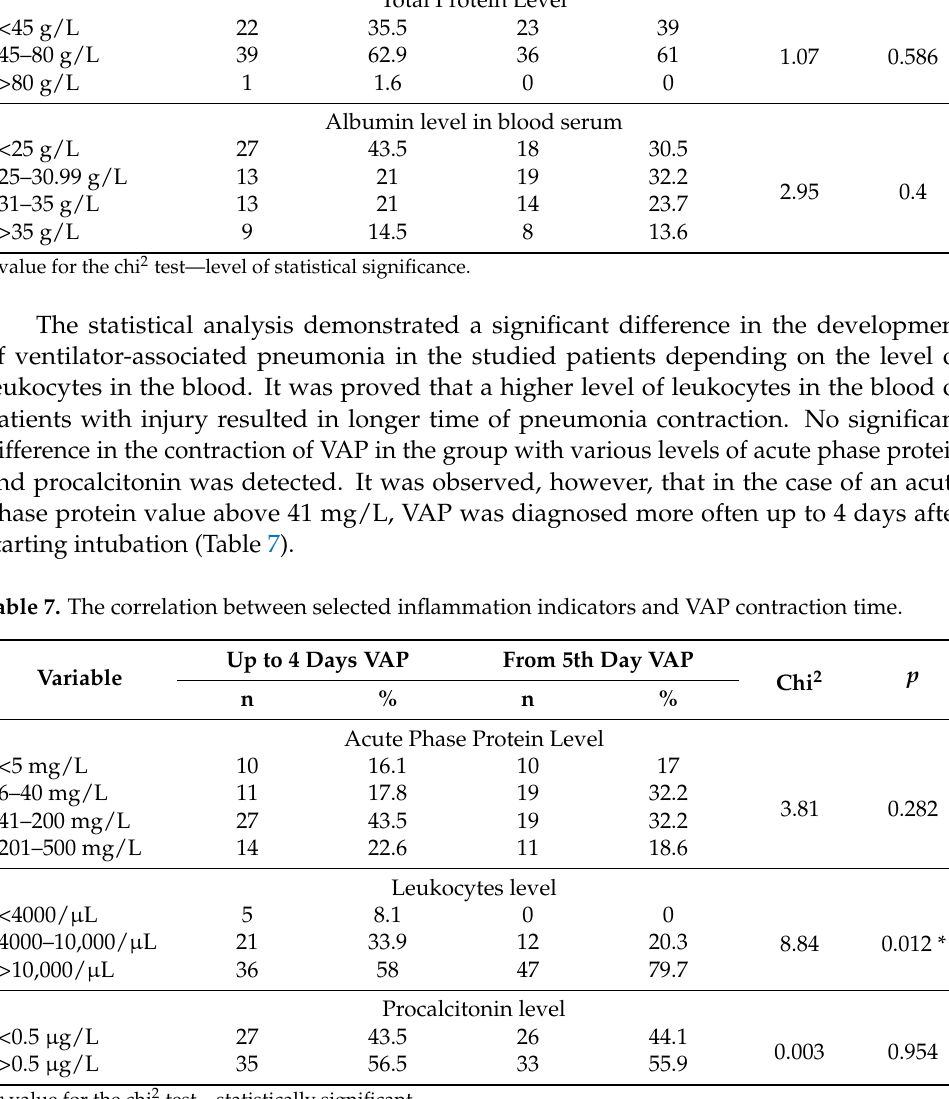
Table 6. The correlation between selected parameters of nutritional status and VAP contraction time. Up to 4 Days VAP Variable